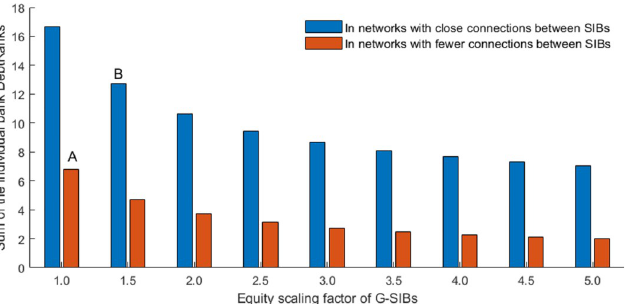
Fig 2. Systemic vulnerability in different networks and with different capital surcharges for SIBs. With the implementation of capital surcharges for G-SIBs, banks’ equity increases, but the interlinkages remain the same in Fig 1(a) and